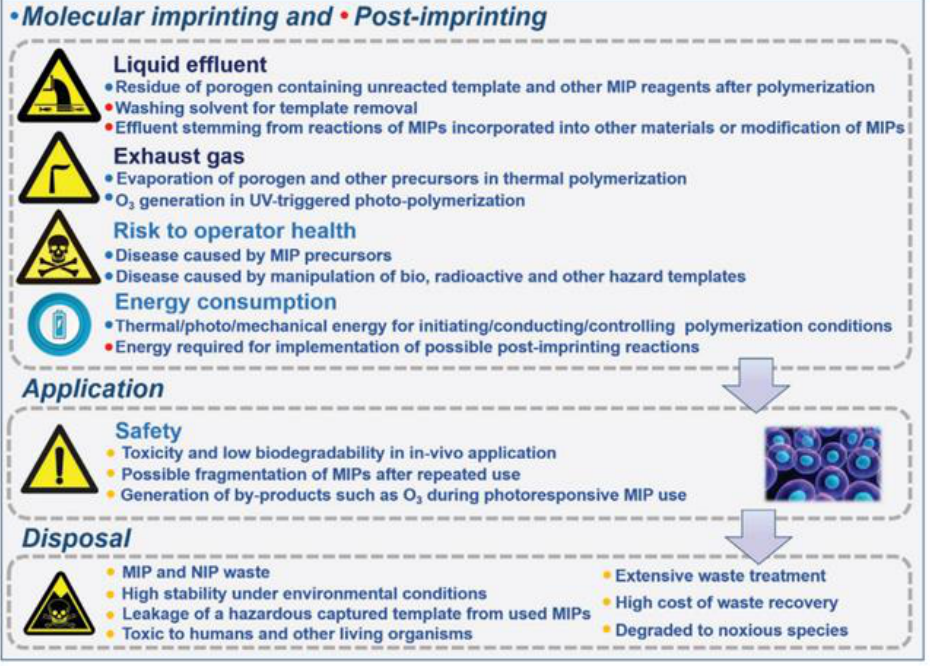
Figure 6. Criticism of unsustainable molecular imprinting technology covering imprinting and post-imprinting application and disposal. (Reprinted with permission from Ref. [132]. Copyright 2021 John Wiley and Sons.)